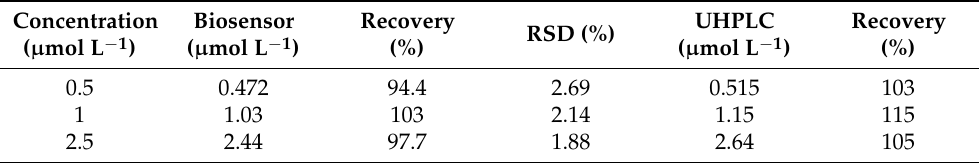
Table 4. Rutin serum sample determinations using electrochemical